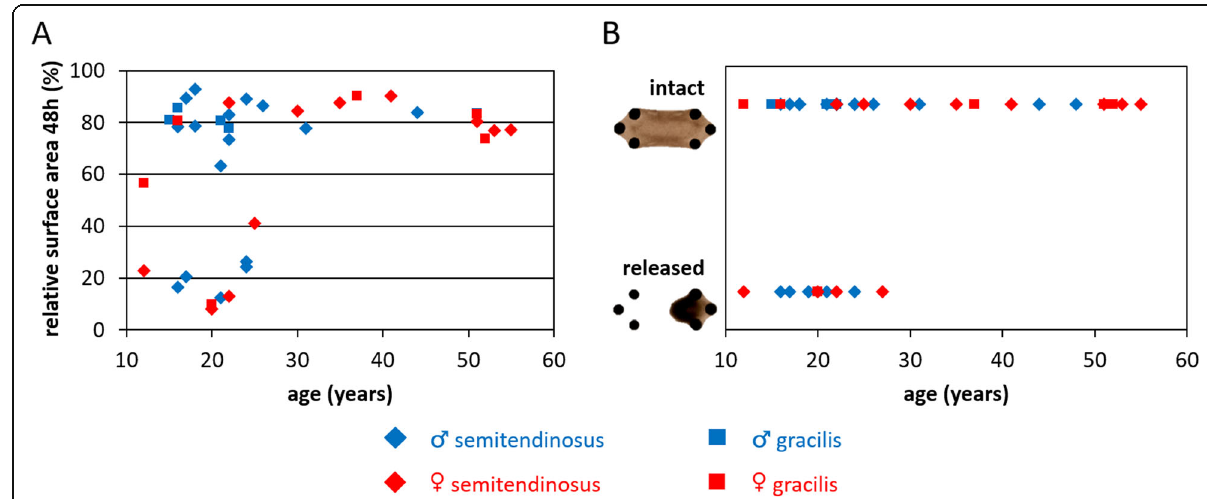
Fig. 3 Micro-tissues representative for younger patients occasionally released from the posts during induced remodeling. a Top-view surface area after 48 h remodeling relative to 0 h, and b micro-tissues staying intact or releasing from remaining posts compared to patient age. Significant age-dependencies were detected for both the relative surface areas and micro-tissues staying intact versus those that released. n =